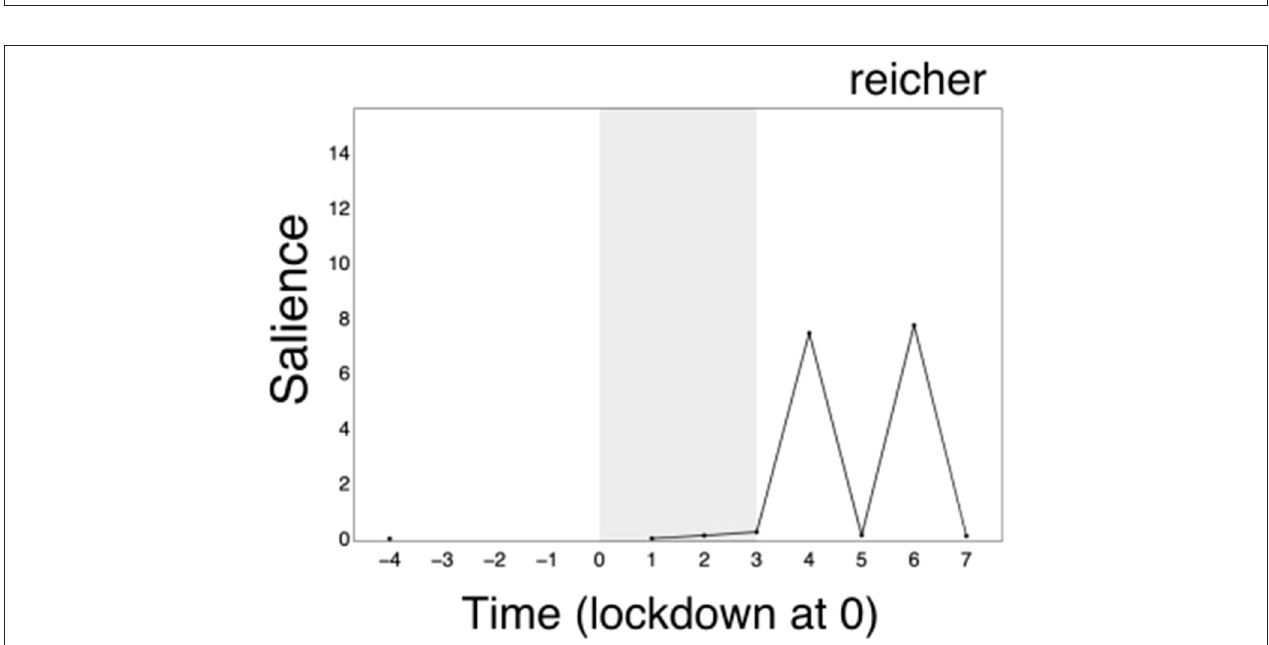
FIGURE 4 | Qualitative inference identified Stephen Reicher as an additional actor. Reicher emerged on the topic of behavioural science toward the latter part of the 24-week time period, corresponding with a surge in salience ( + 6).